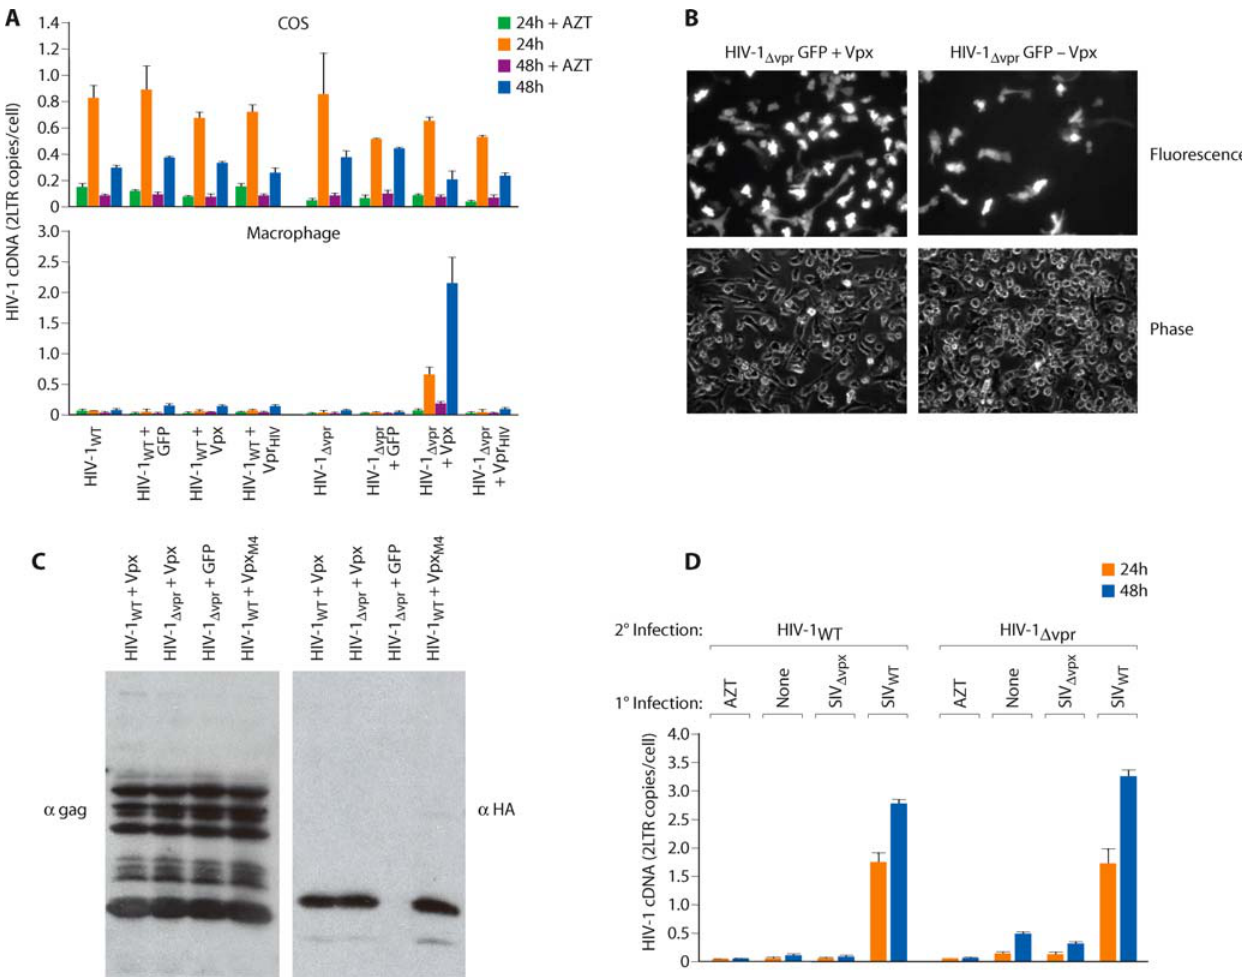
Figure 5. HIV-1 is sensitive to the macrophage restriction and SIV Vpx but not HIV-1 Vpr antagonizes the restriction. ( A) HIV-1 Vpr and SIV Vpx proteins were packaged in HIV-1 WT or HIV-1 D vpr viruses by cotransfection (for controls, viruses were transfected with an empty vector or a GFP-expressing vector). The infectivity of those viruses for COS (upper panel) and macrophages (lower panel) was then determined from levels of viral cDNA (2-LTR circle) at 24 and 48 h post infection. (B) Infection of macrophages with GFP-expressing HIV-1 D Vpr variants in which Vpx was ( + ) or was not ( 2 ) packaged. GFP positive macrophages (representative fields) were visualized 48 h post infection ( C ) Packaging of Vpx proteins in wild type and Vpr deleted HIV-1 ( D) Vpx delivered to macrophages by SIV WT infection enhances the permissivity to HIV-1 WT and HIV-1 D vpr infection. Macrophages were first infected (1 u infection) with wild type or D Vpx SIV variants, left uninfected (none) or treated with AZT. After 8 h, these cells were super-infected (2 u infection) with WT or D Vpr HIV-1 variants and HIV-1 infection (2-LTR cDNA synthesis) was determined 24 and 48 h later (error bars are s.d. of 3 replicate PCRs of a single DNA sample).